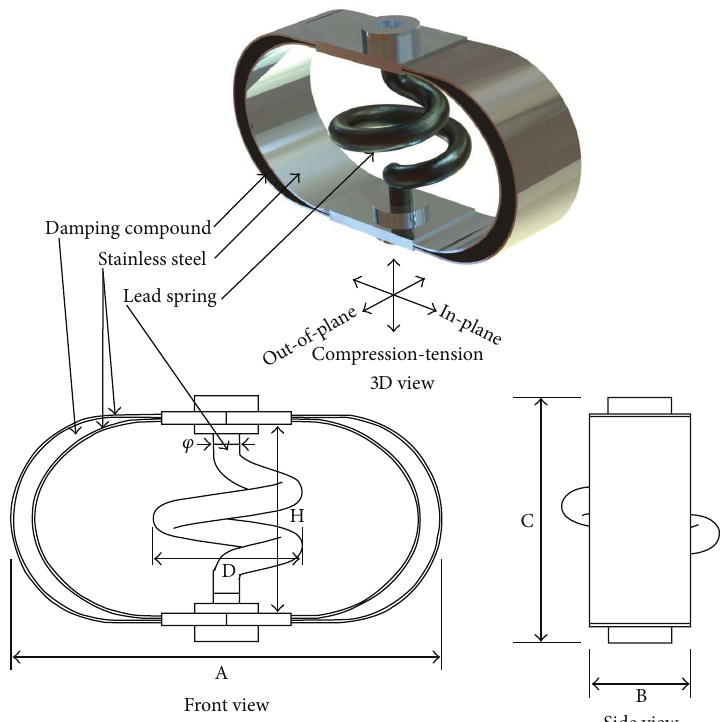
Figure 1: LRELS dimensions and loading